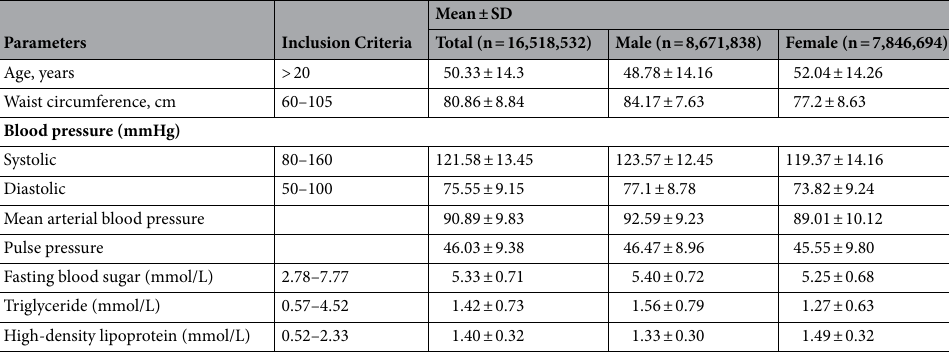
Table 1. General characteristics of the participants. Mean arterial blood pressure = (systolic blood pressure + 2 × diastolic blood pressure)/3; Pulse pressure = (systolic blood pressure − diastolic blood pressure). SI conversion factors: to convert fasting blood sugar to mmol/L, multiply by 0.0555; triglyceride to mmol/L, multiply by 0.0113; high-density lipoprotein to mmol/L, multiply by 0.0259. SD standard deviation.